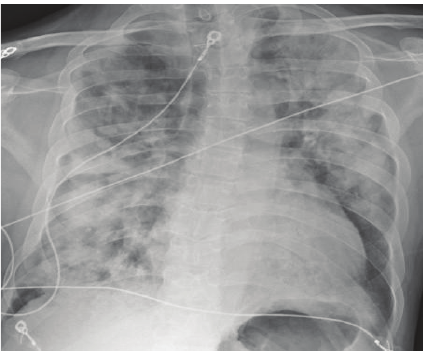
Figure 1: Chest X-ray showing diffuse bilateral patchy infiltrates at